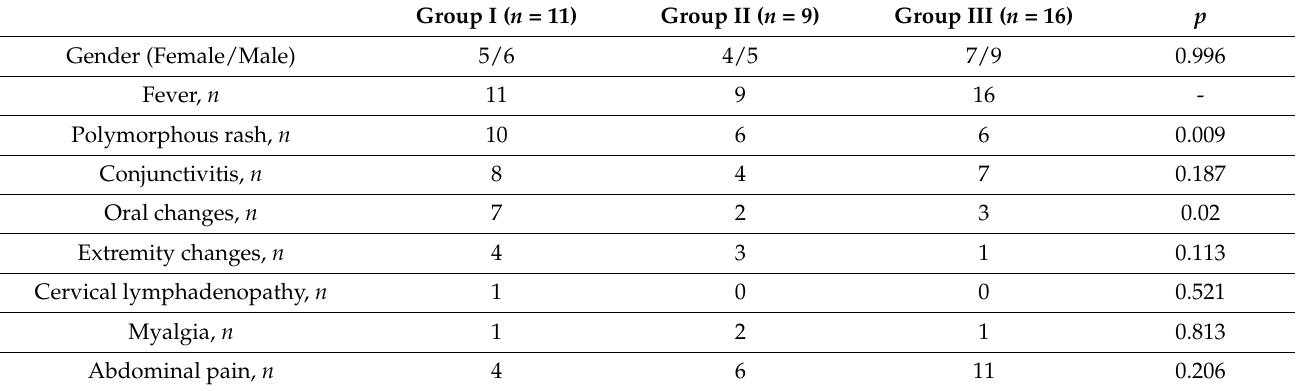
Table 2. Comparison of demographic and clinical features and treatments of